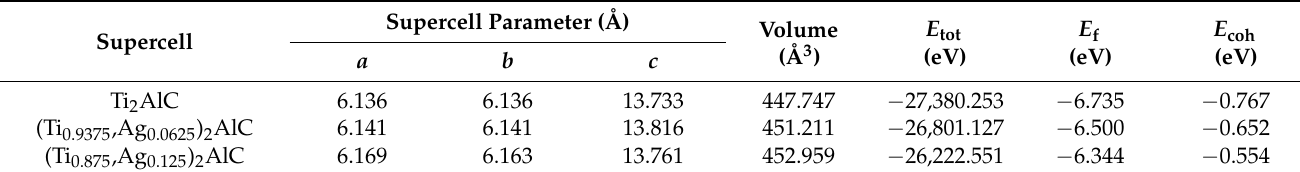
Table 4. Effect of substitution ratio of Ag for Ti on lattice structure and stability of (Ti 1 − y , Ag y ) 2 AlC supercells. Supercell